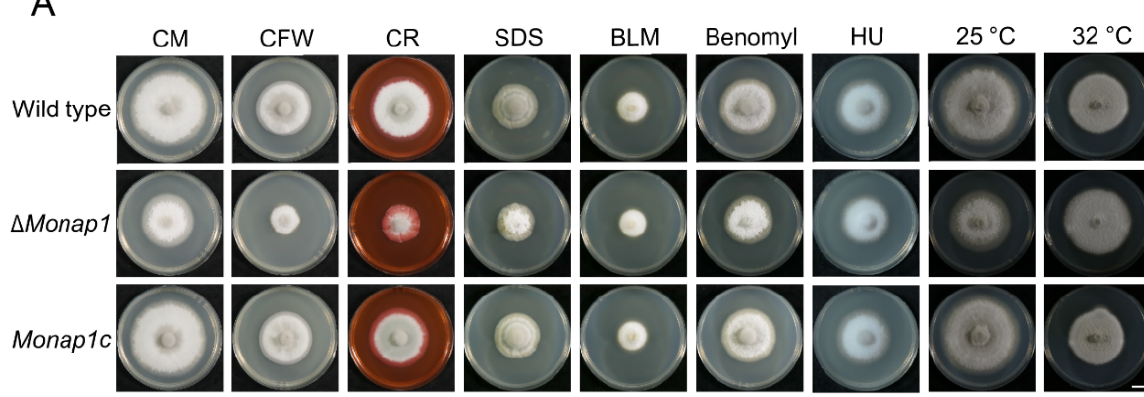
Figure 6. MoNAP1 is involved in the cell wall integrity (CWI) pathway and microtubule dynamics. ( A ) Mycelial colonies of the wild type, ∆ Monap1 and Monap1c strains cultured in CM containing 75 μ g mL − 1 CFW, 600 μ g mL − 1 CR, 0.004% SDS, 35 μ g mL − 1 BLM, 15 μ g mL − 1 benomyl, and 2 mM HU in darkness at 25 °C for 9 days. For the temperature-sensitivity assay, the wild type, ∆ Monap1 and Monap1c strains were cultured in CM at 25 °C or 32 °C under a 16 h light and 8 h dark cycle for 9 d. ( B ) Relative growth rate (%) of mycelial colonies in 75 μ g mL − 1 CFW, 600 μ g mL − 1 CR, 0.004% SDS and 35 μ g mL − 1 BLM, 15 μ g mL − 1 benomyl, 2 mM HU and 32 °C growing conditions. n = 5 independ- ent biological replicates. Error bars represent the standard deviations. The data were analyzed by GraphPad Prism 8.0 and significant differences compared with the wild type were estimated by multiple t tests: ** p < 0.01.